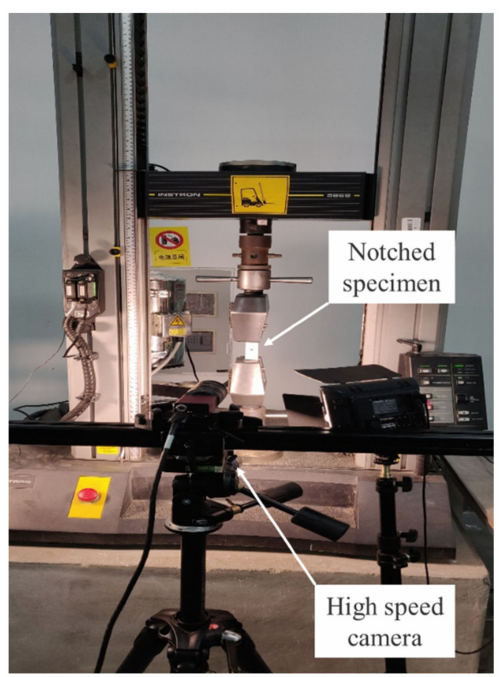
Figure 5. Experimental set-up for digital image correlation (DIC) testing under tension